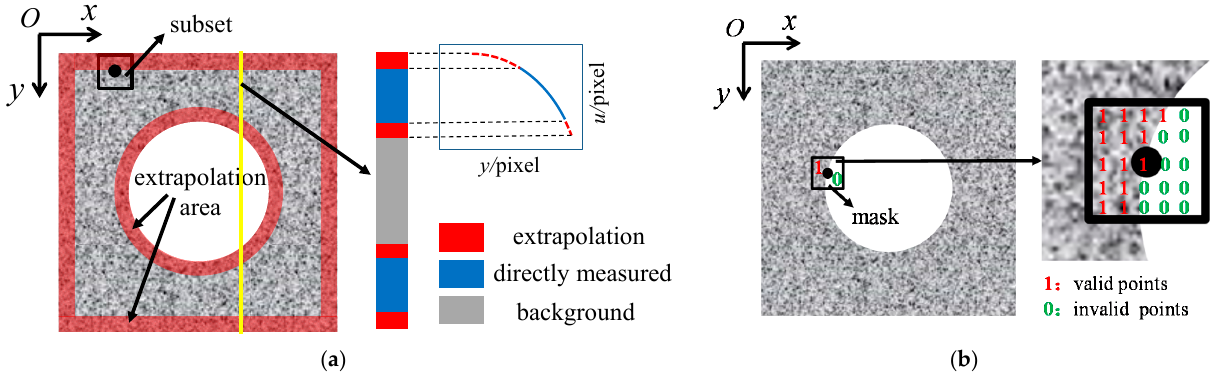
Figure 3. Conventional methods for boundary displacement calculation: ( a ) Extrapolation method and ( b ) half-subset method.